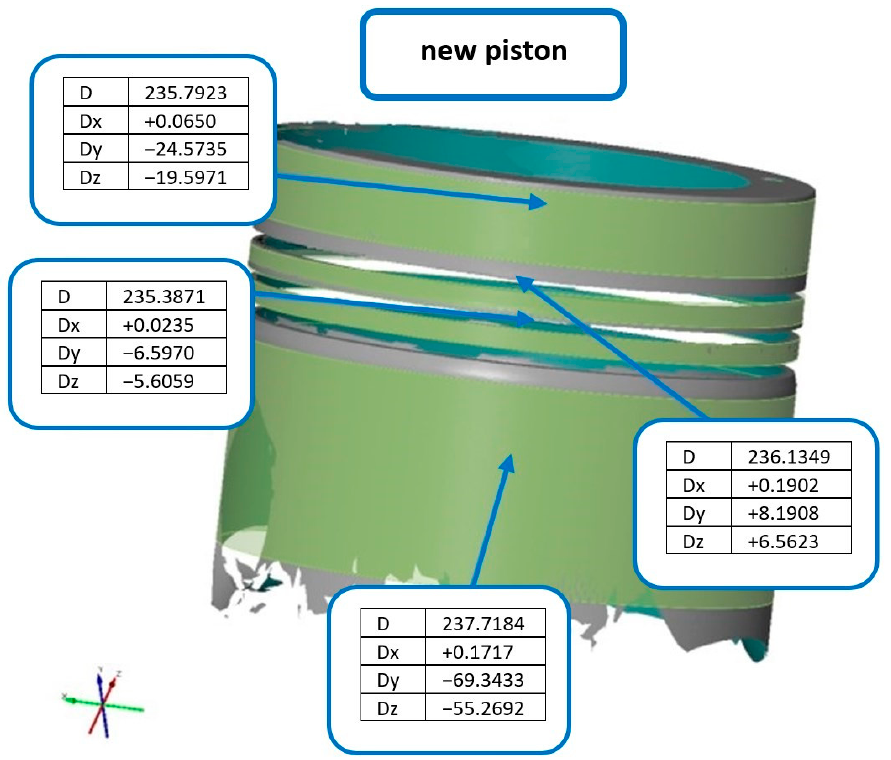
Figure 9. Measurement points on the individual piston grades (results contained in Table 1).